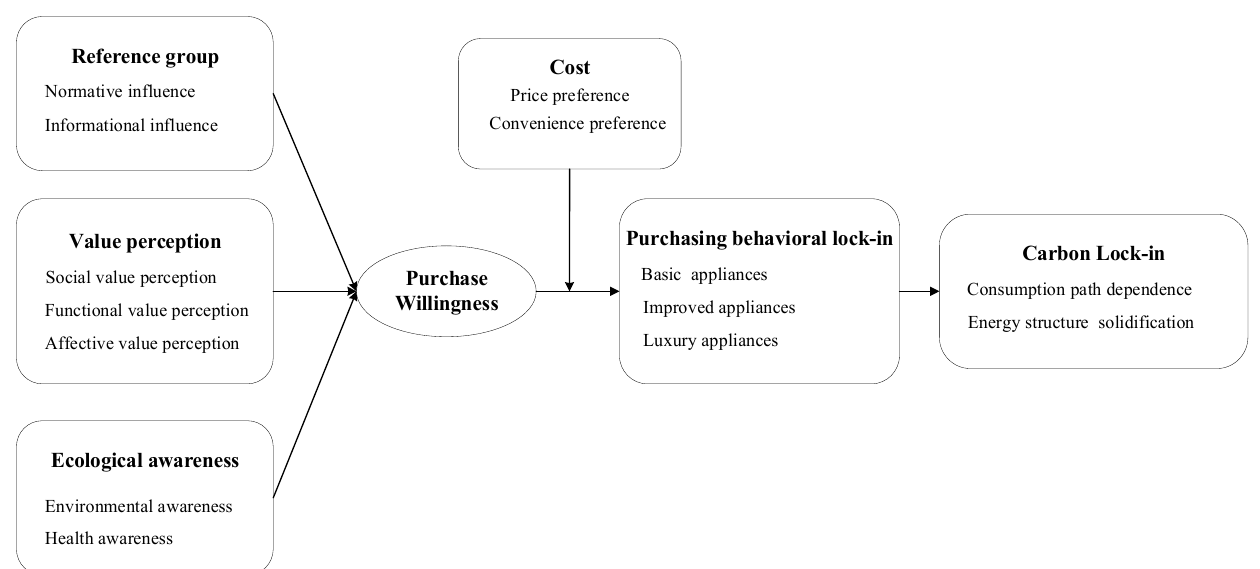
Figure 3. Theoretical model of the formation mechanism of carbon lock-in effect in the purchasing process of household appliances.